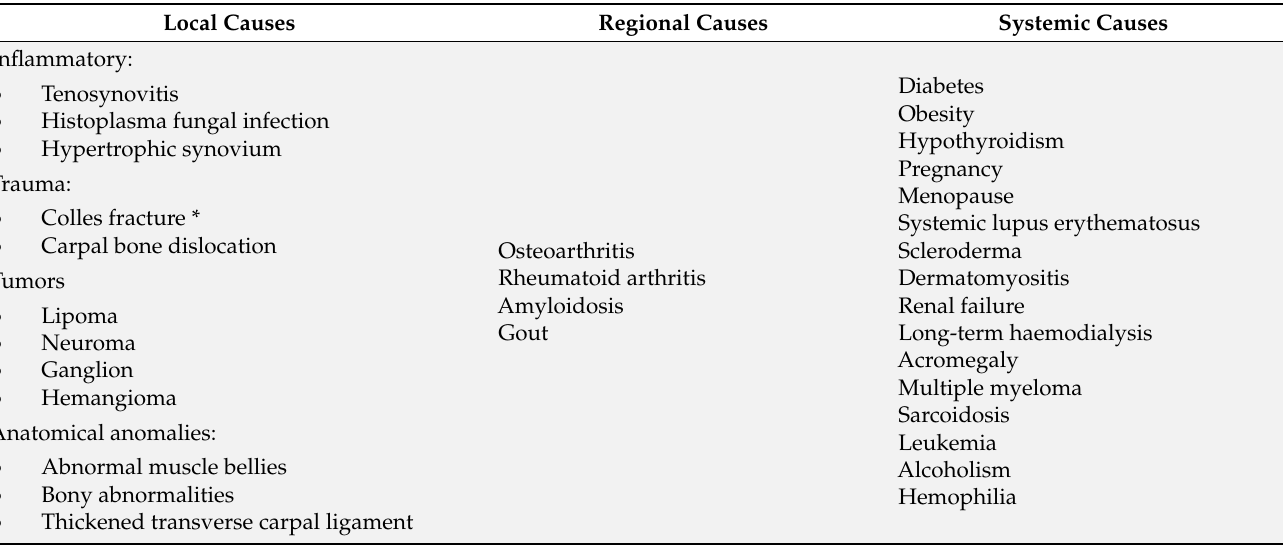
Table 1. Causes of the chronic form of Carpal Tunnel Syndrome. *—defined as a distal radius fracture with dorsal comminution, dorsal angulation, dorsal displacement, radial shortening, and an associated fracture of the ulnar styloid